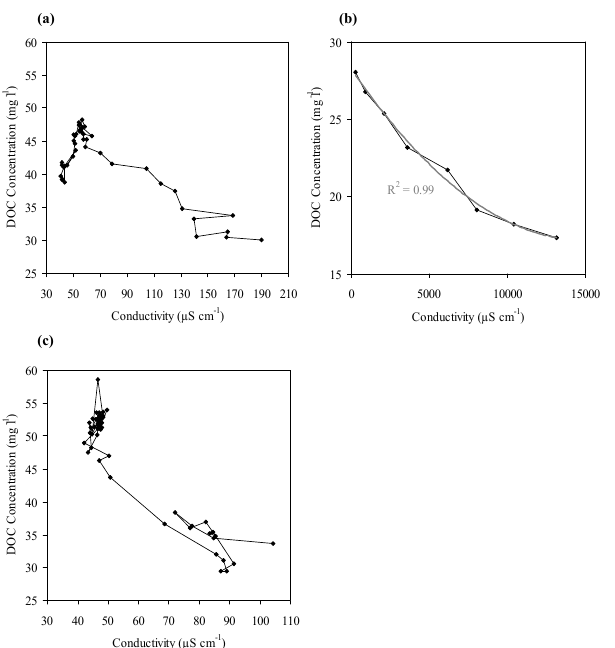
Fig. 4. Fig. 4. Temperature corrected EC (as a proxy for salinity) vs DOC concentration plots for samples from the River Sebangau in the dry season (a) 0–126km from source and (b) 126–150km from source (polynomial 2nd order relationship; r 2 = 0 . 99) and the wet season (c) 0–150km from source. Note different y axis scale in Fig. 4b.